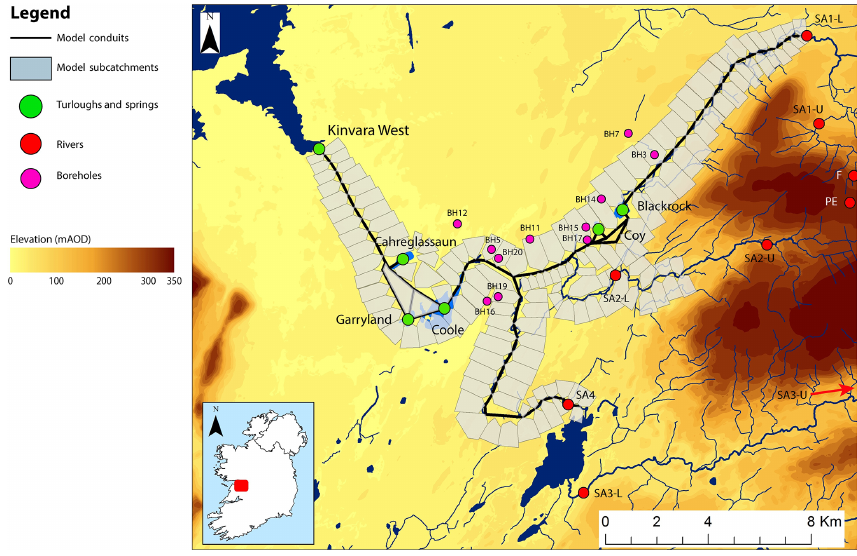
Figure 3. Pipe network model schematic and sampling locations of turloughs, rivers and boreholes. Note: the additional “U” and “L” labels on the river names refer to upper and lower sampling locations